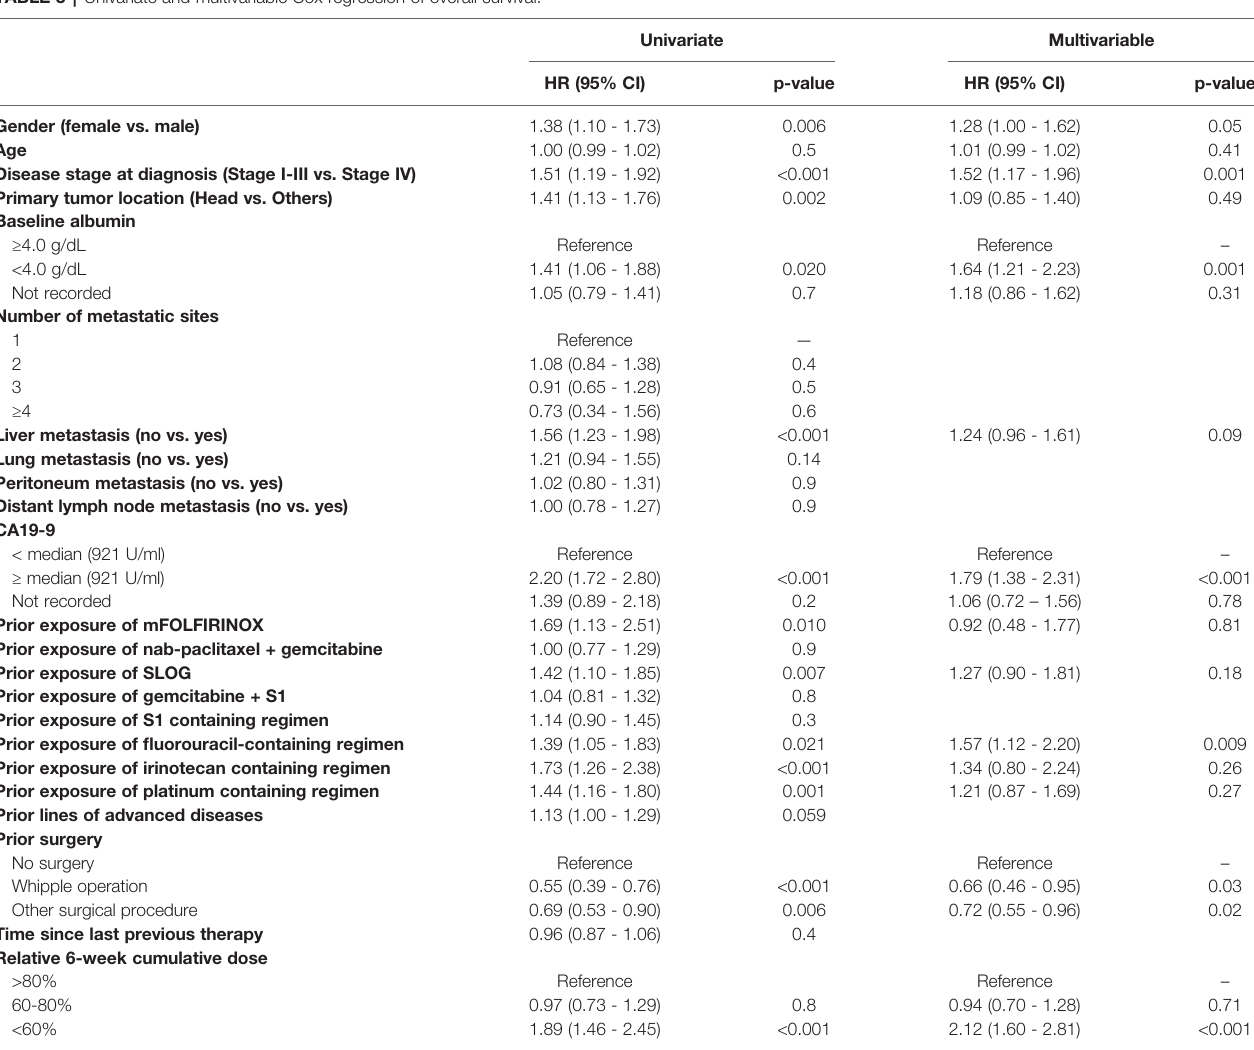
TABLE 3 | Univariate and multivariable Cox regression of overall